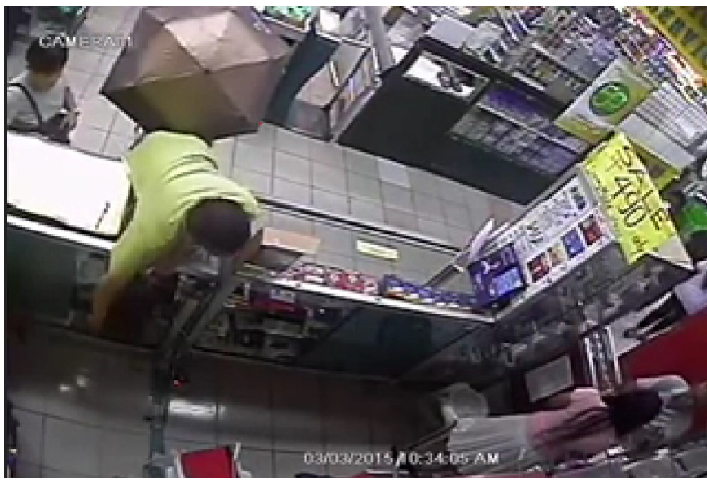
Figure 3. Sample frame from the UCF crimes shoplifting video dataset.